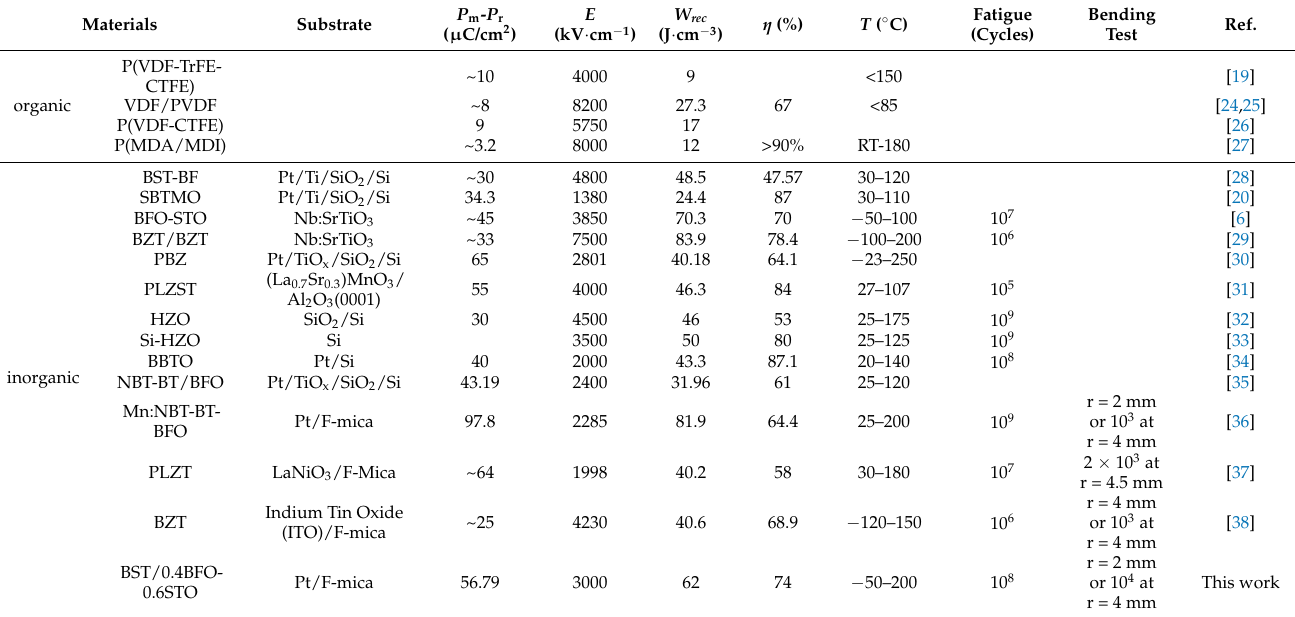
Table 1. Comparison of energy storage performance of different types of